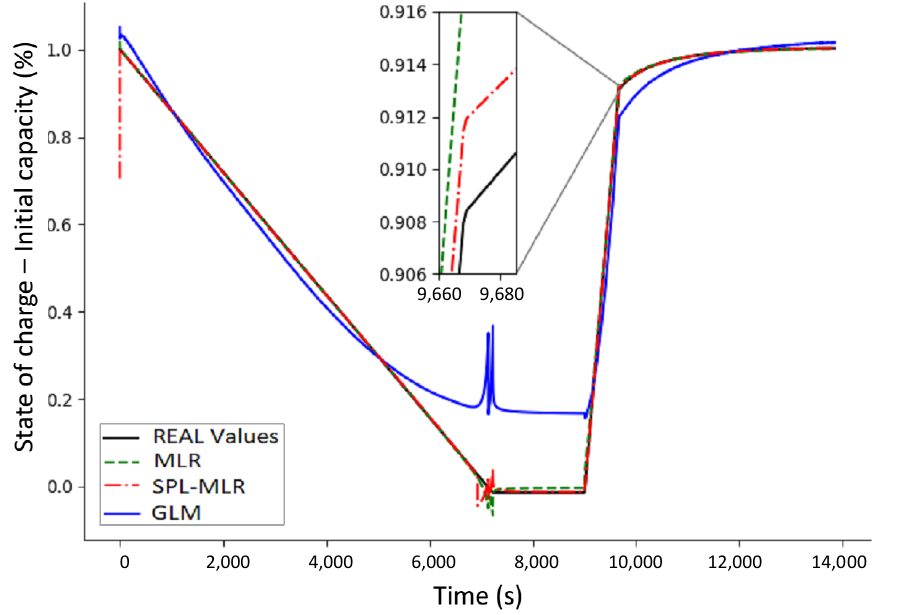
Figure 4. Initial Capacity Curve for GA Training.